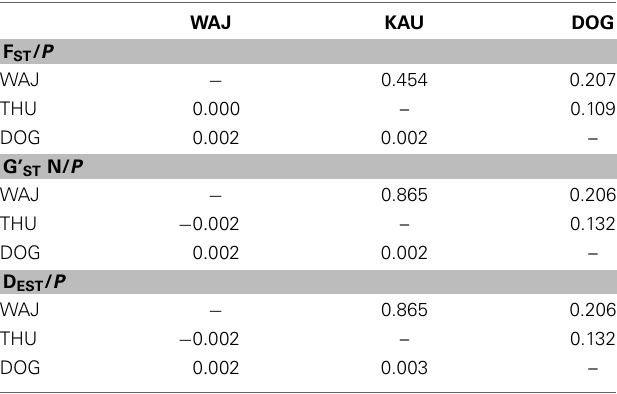
Table 3 | Coefficients for genetic differentiation assessment between populations pairs (below the diagonal) and associated P -values (above the